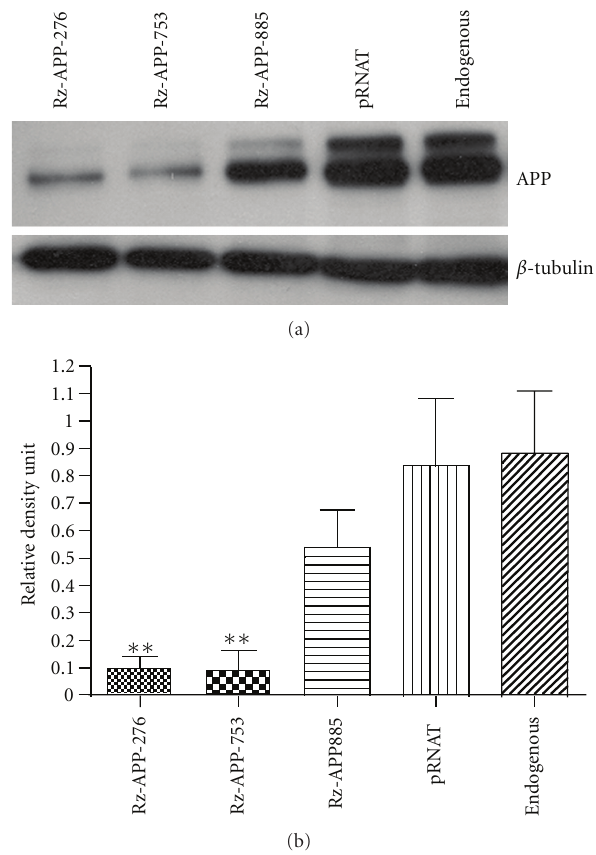
Figure 5: Rz-APP-X ribozymes expression reduces APP levels. (a) Western blotting analysis performed using equal amounts of 20 μ g of extracted protein. APP was immunodetected using a polyclonal antibody (Sigma) recognizing the C-terminus of human APP. The tubulin ( β -tubulin) controlled the amount of sample loaded in each lane. The highest APP reduction (approximately 85%) was obtained with Rz-APP-276 and Rz-APP-753. (b) Densitometric quantifica- tion of the APP lanes in the blot from (a). Relative density unit values were obtained by standardization with the corresponding β - tubulin protein band in each lane. The results in (b) are presented as the means ± SEM from 3 independent experiments. ∗∗ P < 0 .